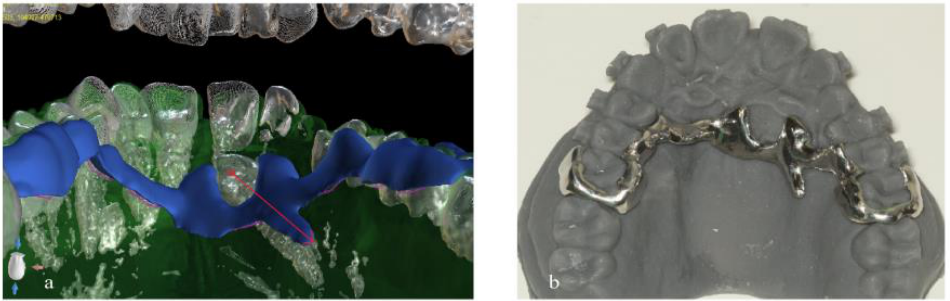
Figure 4. ( a ): The device (blue color), indicating the crown of the canine and the direction of traction (purple arrow). ( b ): The device 3D-printed in biocompatible dental alloy.